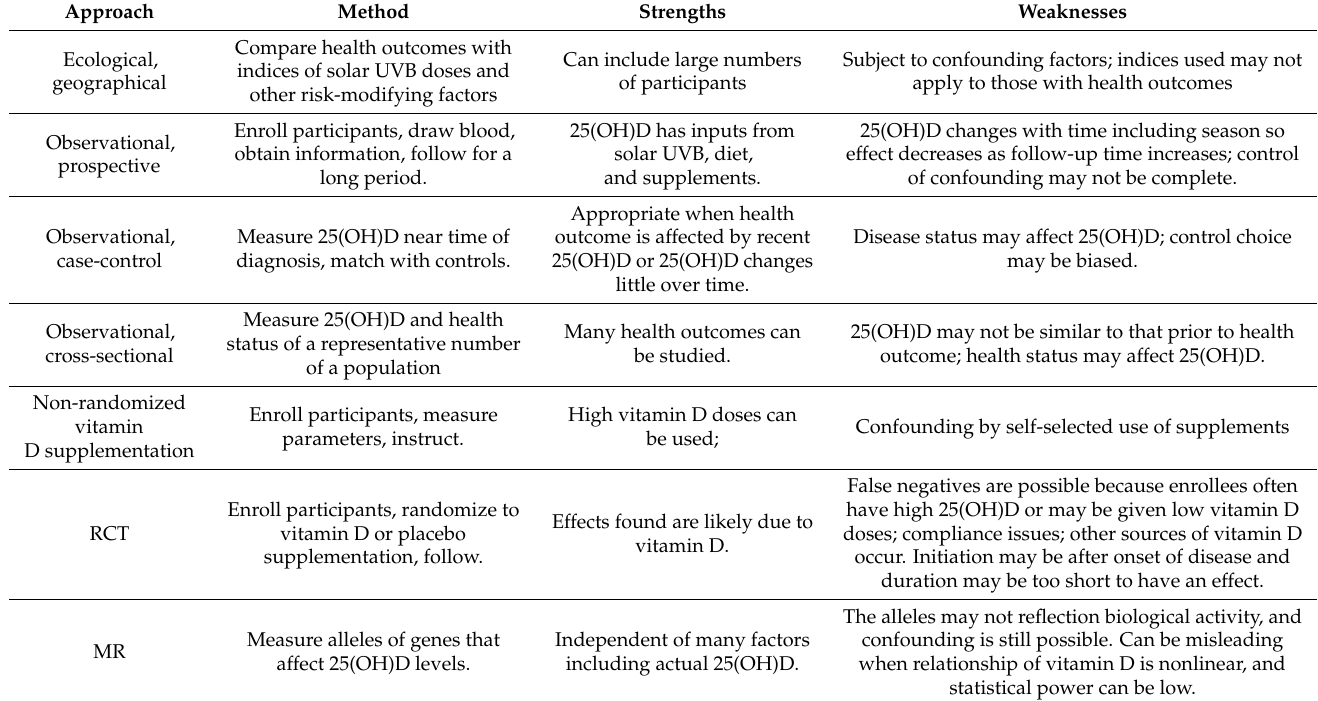
Table 1. Comparison of epidemiological approaches to determine relationships between vitamin D and health outcomes.